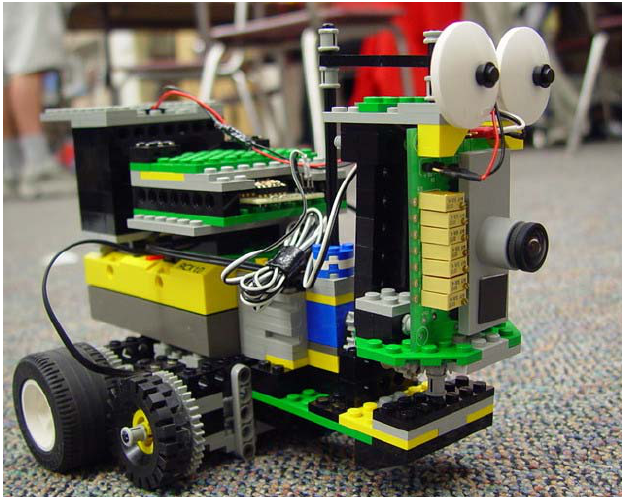
Figure 6 . Tracker chip mounted on a LEGO robot performing a “target exploration task”. Using very little CPU power, this robot is able to simultaneously explore (make random body/head movements), attend (orient the sensor toward high-contrast moving edges) and pursuit (drive towards the